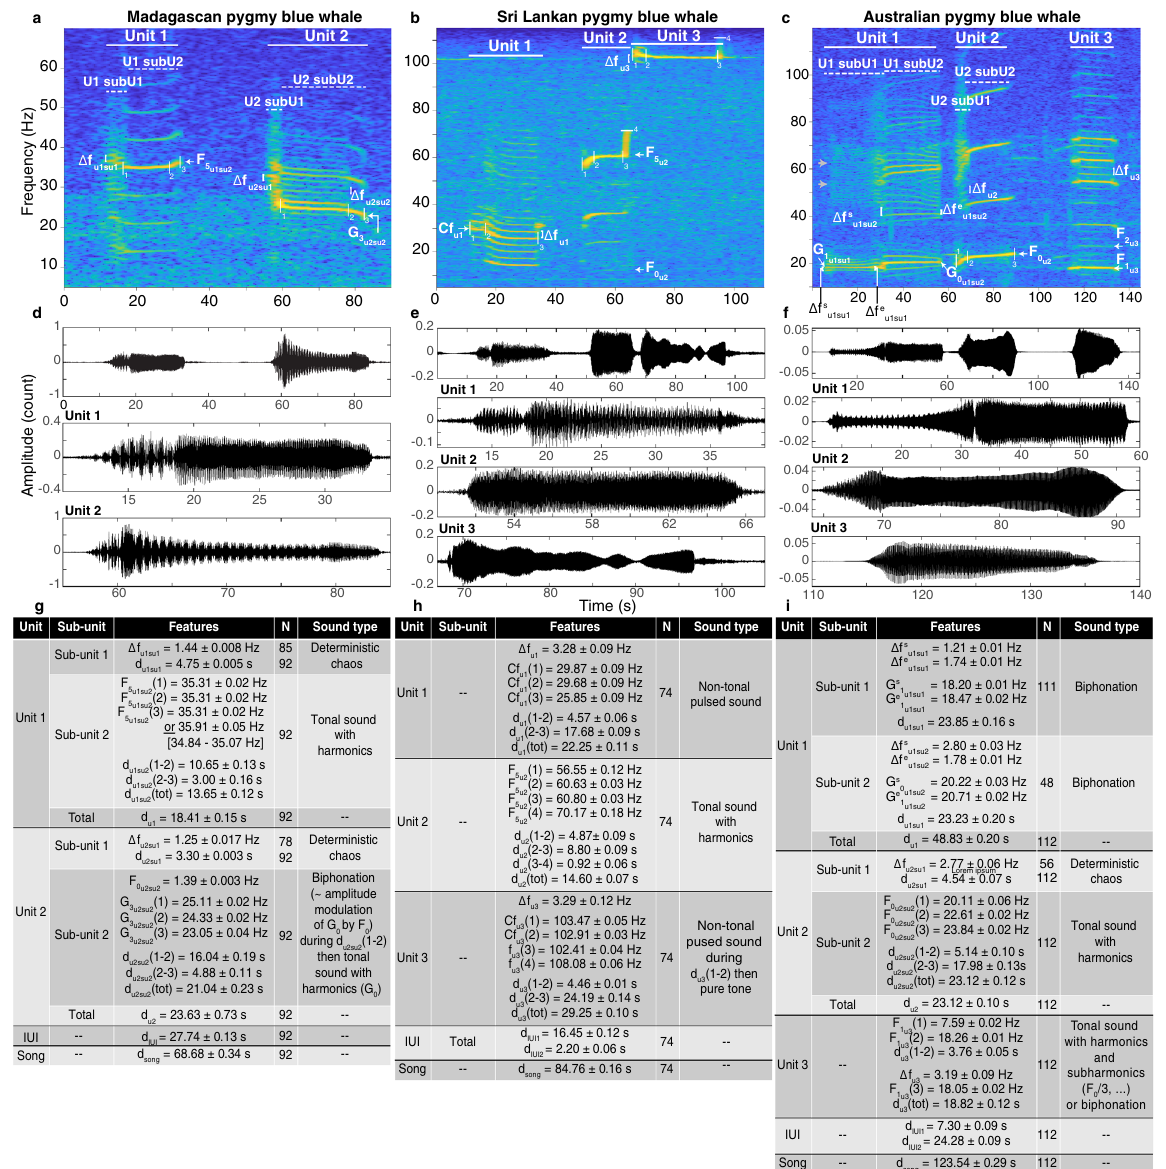
Figure 5. Spectrograms (upper panels) and waveforms (middle panels) of the song of the Madagascan, Sri Lankan and Australian pygmy blue whales, including detailed waveforms to show the internal signal structure. The Madagascan song was recorded off Crozet Island (CTBTO records, site H04S1) in April 2004, the Sri Lankan song was recorded at DGN (CTBTO records, site H08N1) in April 2009 and the Australian song was recorded at Perth Canyon in March 2008 (IMOS records). (Spectrogram parameters: Hamming window, 1024- point FFT length, 90% overlap. Note that the axes differ among plots.) And measurements (mean ± s.e., lower panels) of the acoustic features of the different song types. N is the number of measurements, u i su j stands for unit i subunit j where i and j are the unit and subunit numbers, (cid:31) f designates the frequency difference between the sidebands, f and d are the frequency and duration of the feature indicated in subscript, and when present, the number in brackets refers to the point measured as indicated on the corresponding spectrogram. F x or G x designate the x th harmonic of a sound, and Cf designates the carrier frequency of a